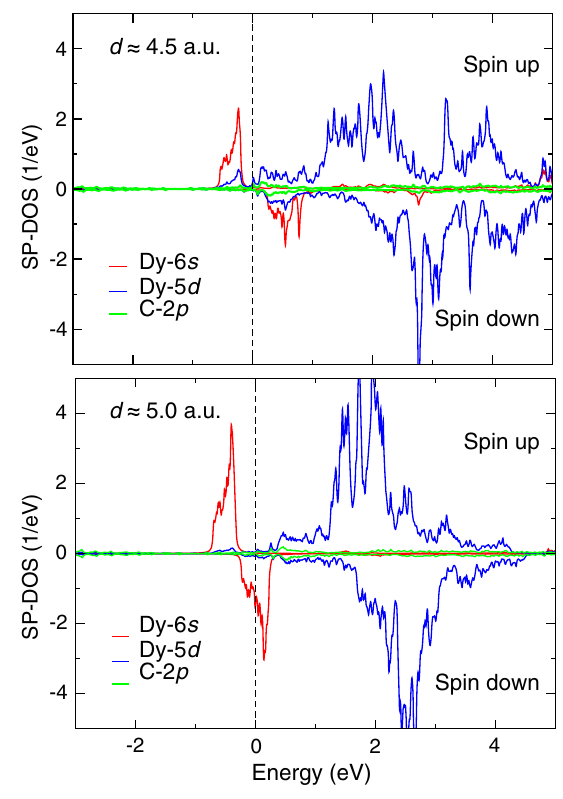
for 6 s and 5 p shells of F . A F